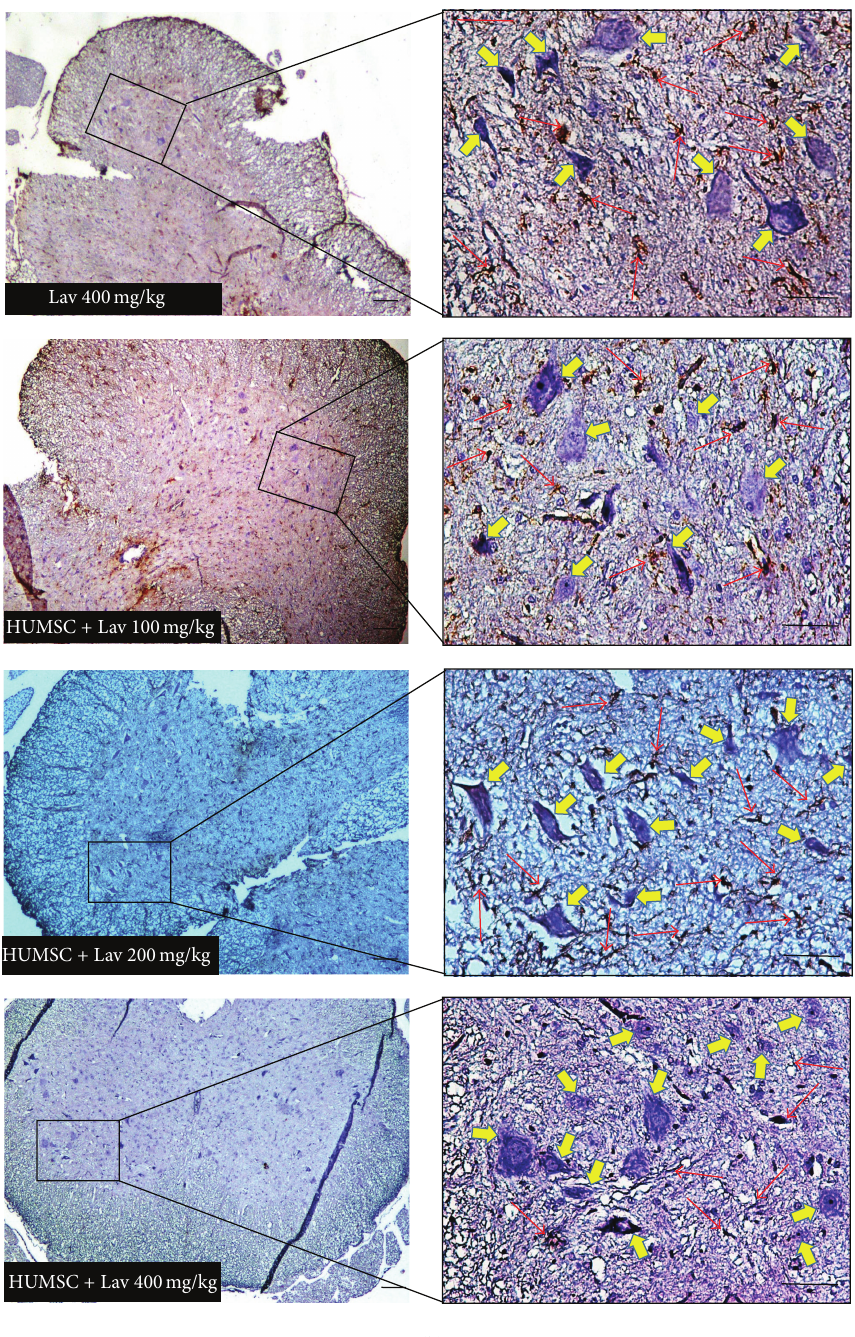
Figure 4: Administration of L. angustifolia decreased GFAP expression in the rat spinal cord contusion model transplanted HUMSCs. Intraperitoneal administration of L. angustifolia extract daily for 14 consecutive days postinjury significantly decreased the levels of GFAP expression in the rat spinal cord contusion model. Data are represented as the mean ± S.E.M. (a) ∗ , ∗∗ , and ∗∗∗ show significant differences between HUMSCs, HUMSCs + Lav 100, 200, and 400, and SCI (Control 1) ( 𝑃 < 0.05 , 𝑃 < 0.0001 , and 𝑃 < 0.0001 , resp.). ### shows significant differences between HUMSCs and HUMSCs + Lav 400 ( 𝑃 < 0.0001 ) (Per 35625 𝜇 m 2 ). (b) Transverse section of spinal cord showing the ventral horn gray matter at the T12-L1 level for all groups on day 56 GFAP-stained images. Yellow arrows indicate VHMNs. Red arrows indicate the GFAP astrocytes. Decreased GFAP astrocytes and increased VHMNs are evident. Bar in 40X = 100 micrometer and bar in 200X = 50 micrometer. (ECLIPSE 5Oi